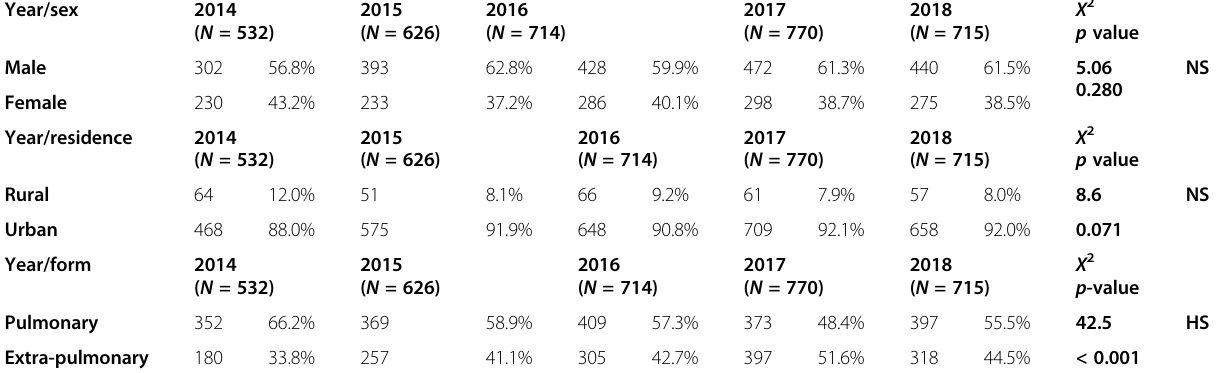
Table 2 Distribution of cases according to sex, residence, and TB form during the study period Year/sex